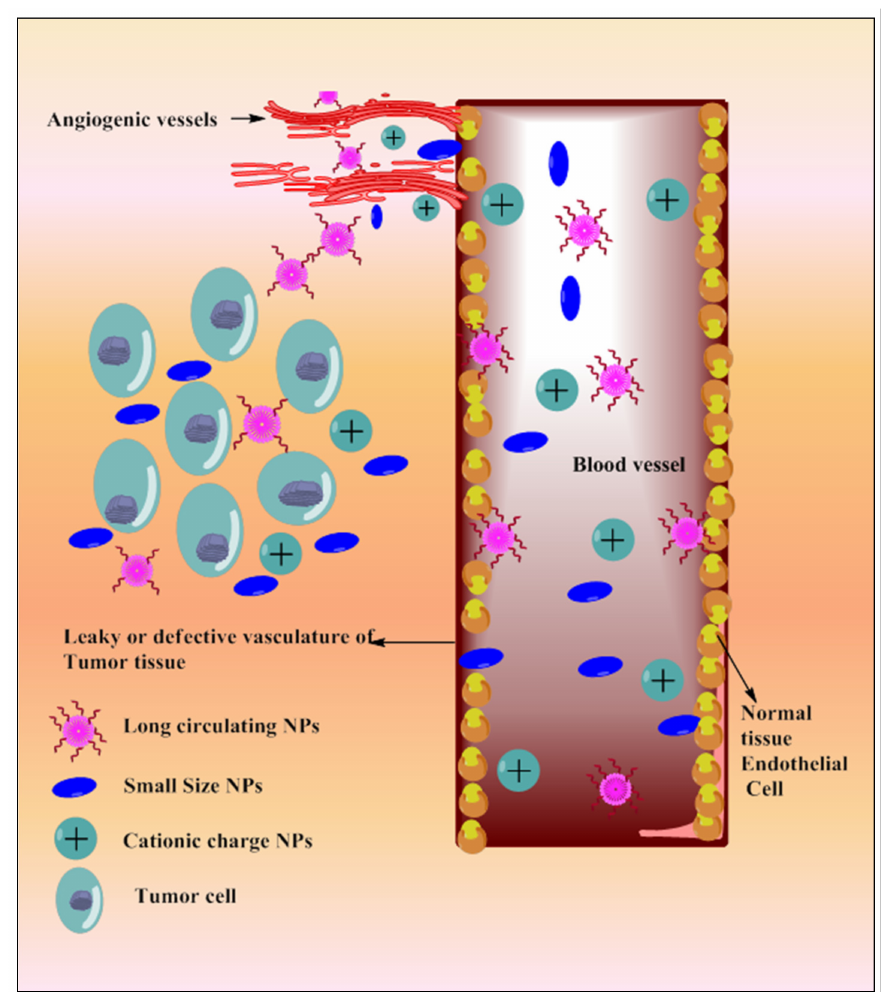
Figure 5. Systemic diagram depicting diverse approaches intended for passive targeting of TQ via